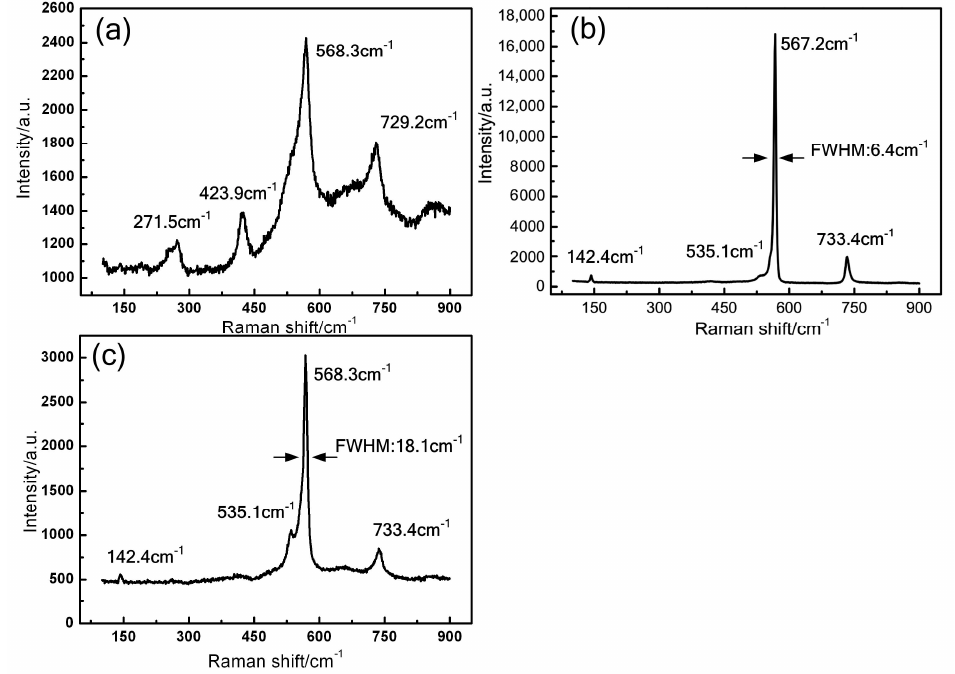
Figure 4. Raman spectra of GaN powder ( a ) and crystals obtained with N 2 pressure of ( b ) 3.6 MPa and ( c ) 4.5 MPa.